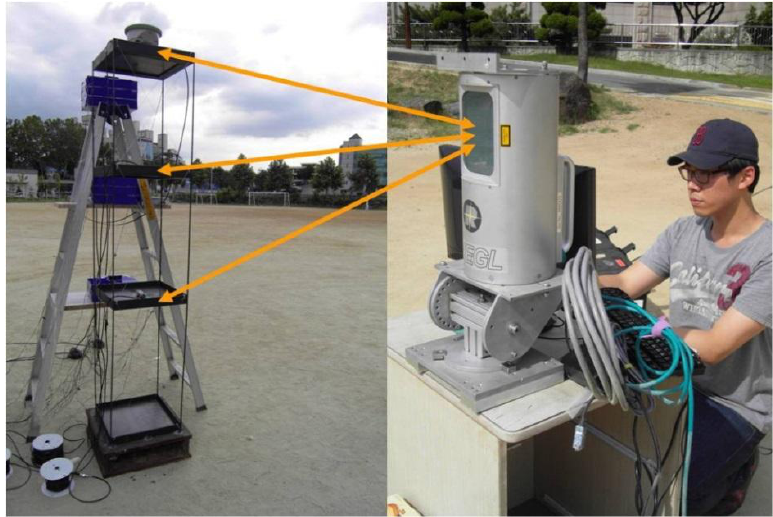
Figure 5. An overall view of experimental setup.